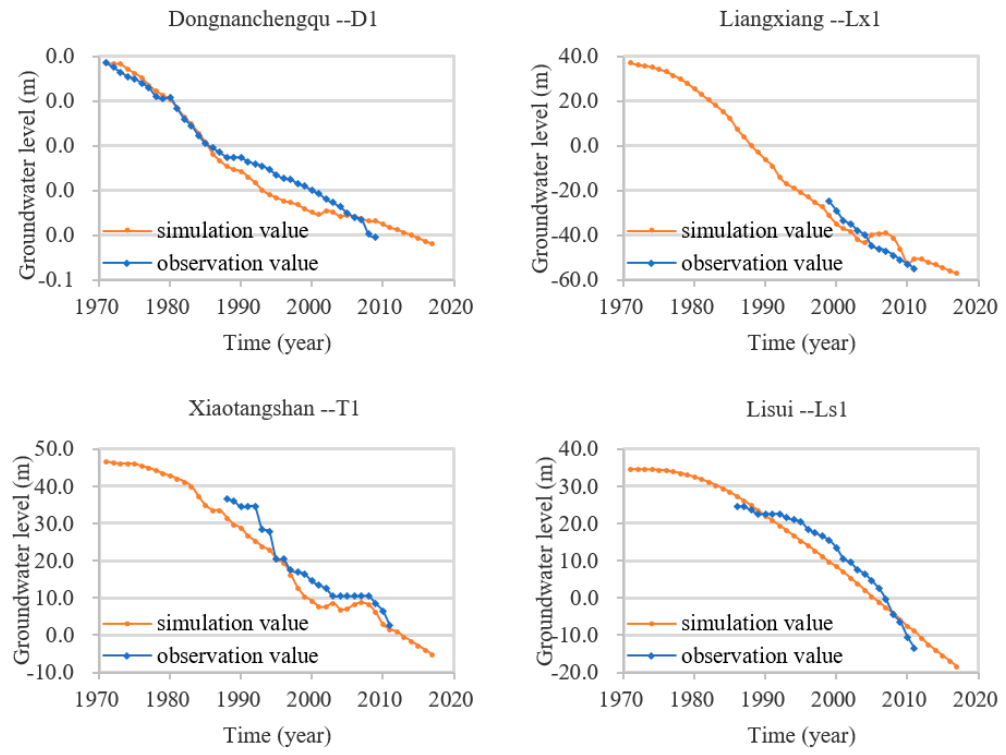
Figure 14. Curves of the observed and simulated hydraulic heads during the simulated period, locations of the observed points are indicated in Figure 10. Table 6. Fitting error of thermal groundwater level in simulation